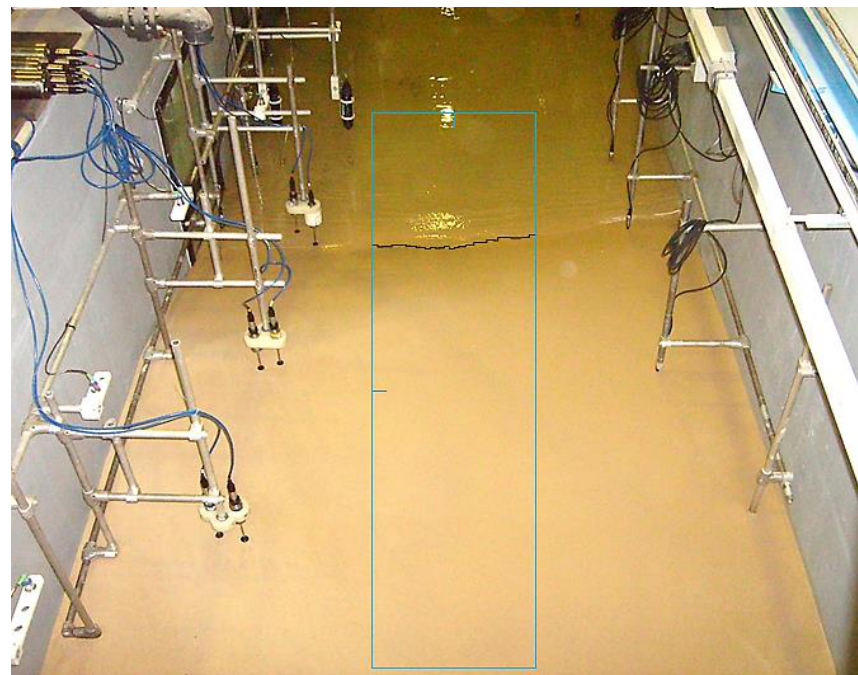
Figure 3. Image of the wave flume after geometric rectification.